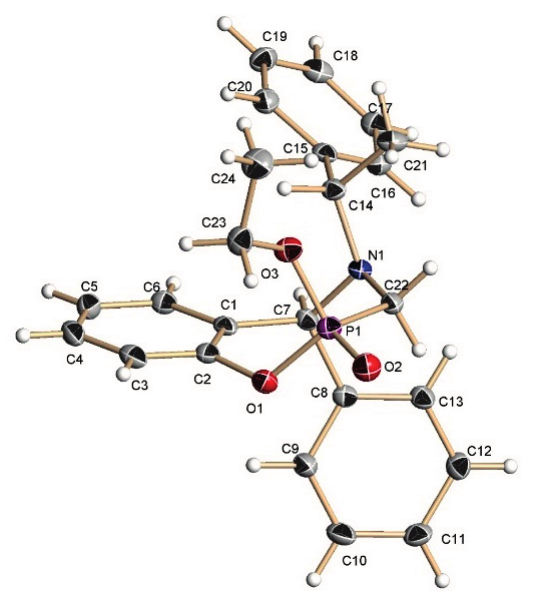
Figure 4. X-ray crystallographic structure of (2 R ,5 S ,1 ʹ S )- 13c